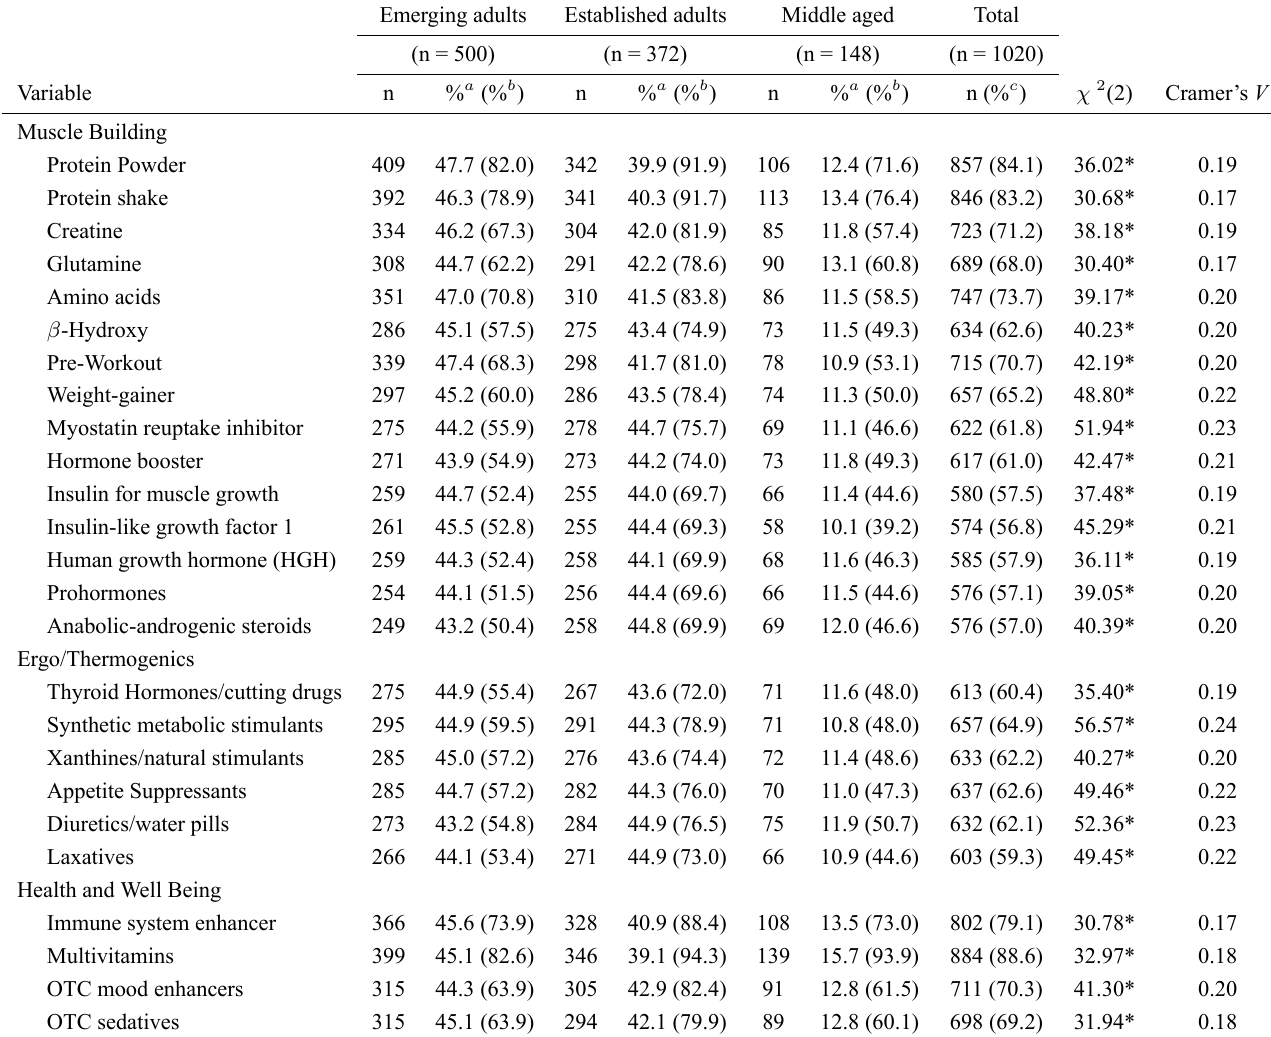
Table 4. Frequencies and chi-square results for individual substance usage according to age